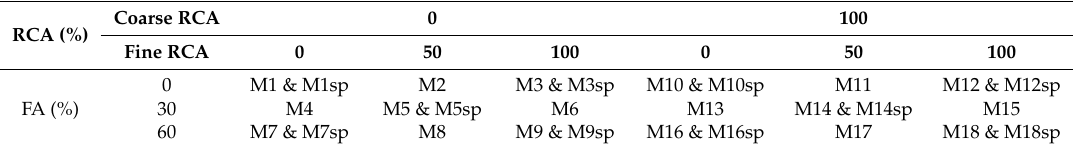
Table 1. Mixes composition; RCA: recycled concrete aggregates; FA: fly